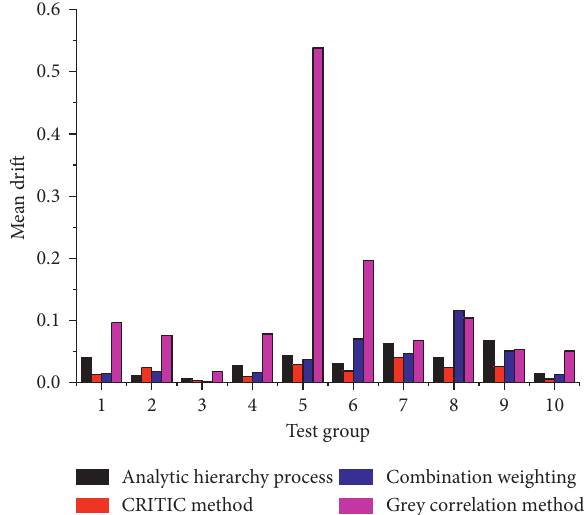
Figure 9: Drift of each evaluation